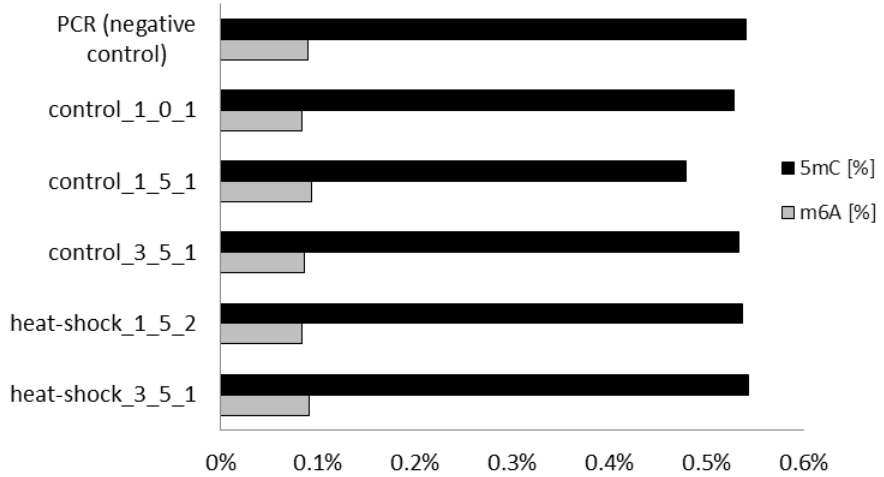
Figure 5. Level of global DNA methylation (5-methylcytosine and N6-methyladosine content) in all contexts (ONT Guppy basecalling software version 3.6.1). Sample names are encoded: hours after HS/number of HS/number of cycles .